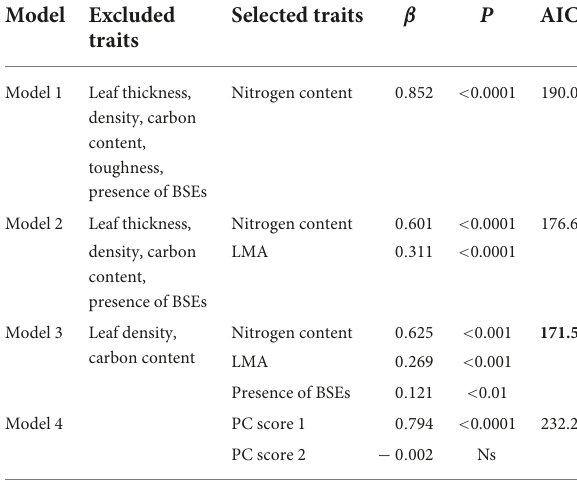
TABLE 8 Comparison of models including different trait combinations to explain the variation in leaf P max .